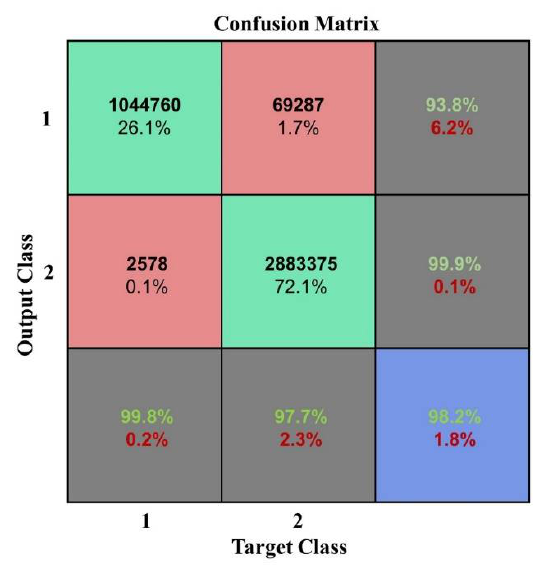
Figure 7. Confusion matrix at a network depth of